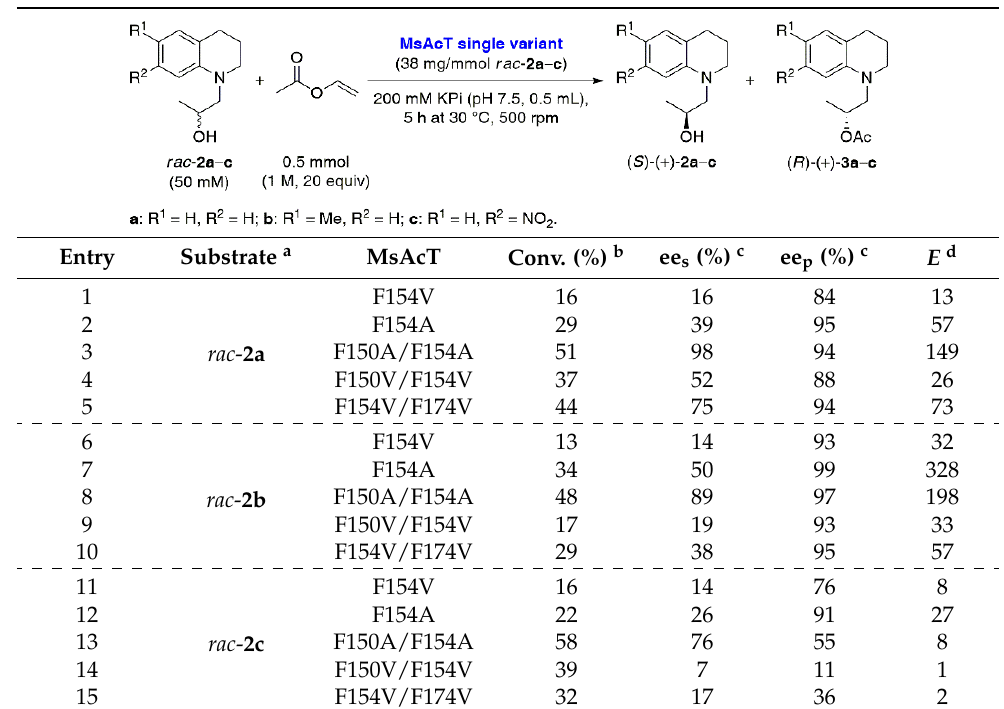
Table 6. Screening conditions for MsAcT-catalyzed KR of rac - 2a – c using vinyl acetate in an aqueous buffer.